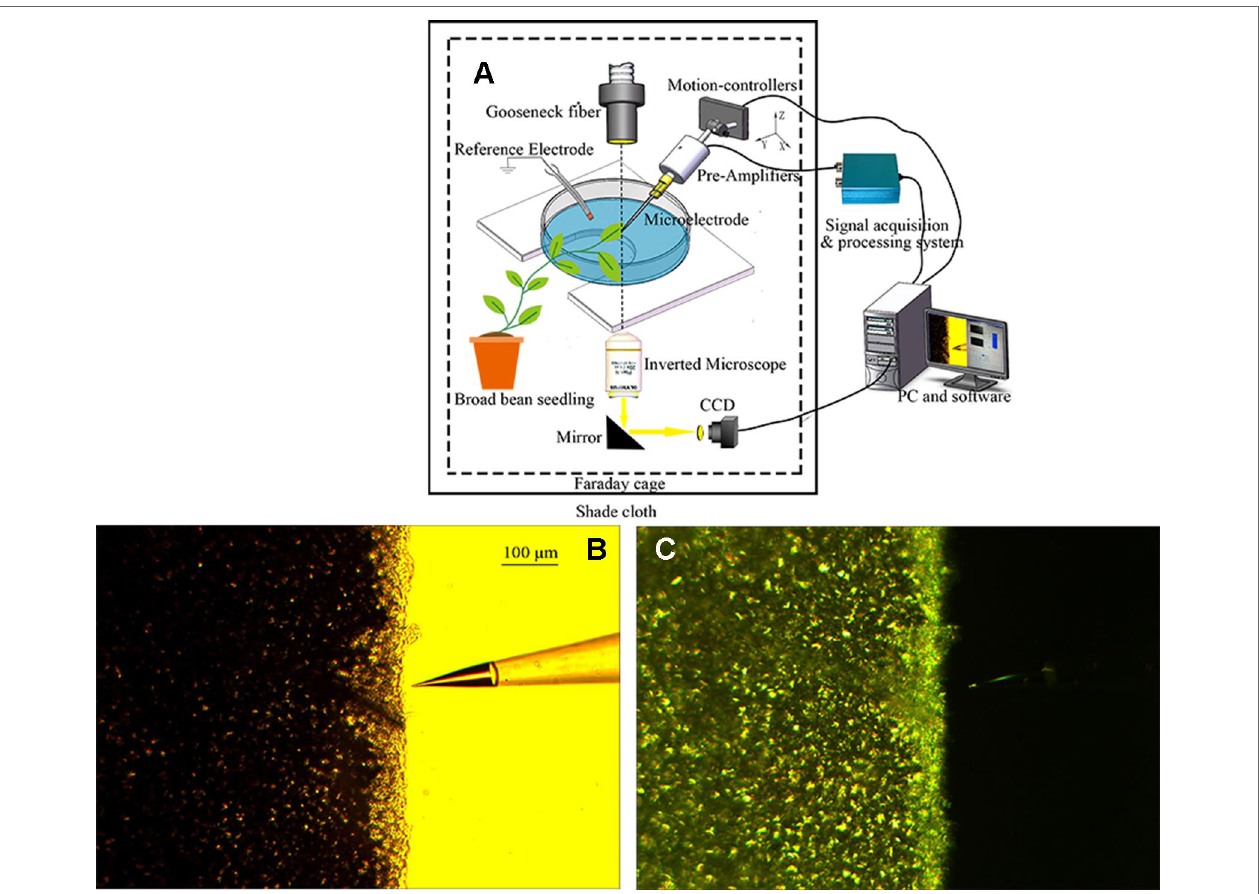
FIgURe 2 | Ion flux measurement in the leaf of a broad bean seedling under periodic illumination/darkness. (a) Schematic diagram of ion flux measurement. (B , C) Measurement of H + flux under periodic illumination/darkness.